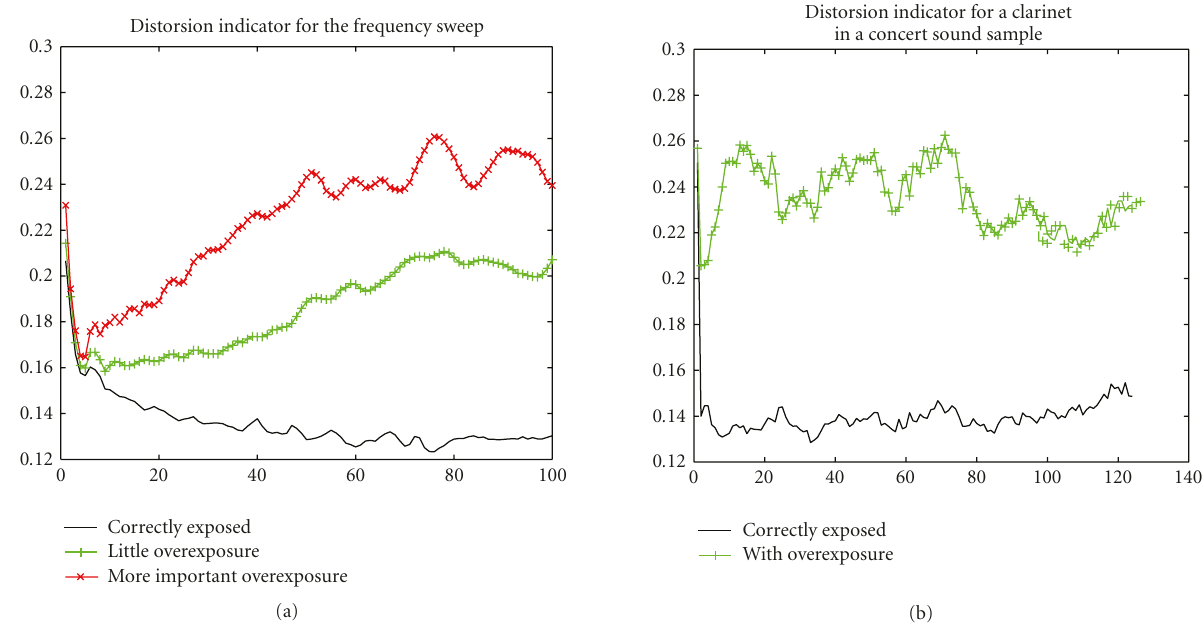
Figure 21: (a): HD-indicator for the frequency sweep test signal (black: correct exposure, green: light overexposure, red: strong overexposure). (b): HD-indicator for music instrument (clarinet) sample (black: correct exposure, green: light overexposure).